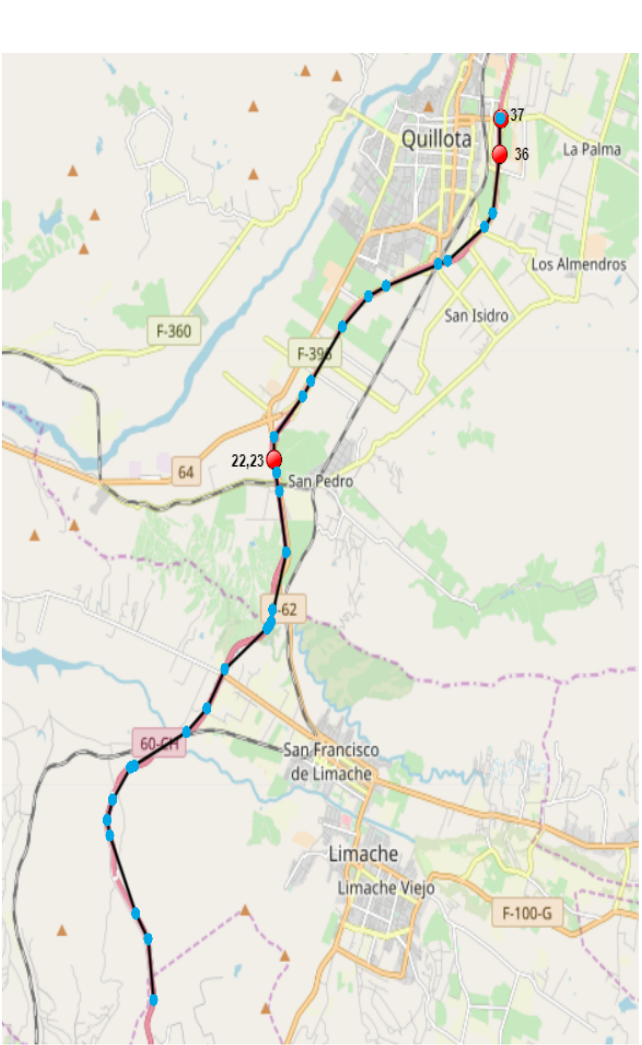
Figure 7. Example 1 of correctly detected outlier trajectory. The light blue points indicate GPS measurements of the complete trajectory, while the red points indicate the points with the highest reconstruction error according to the neural